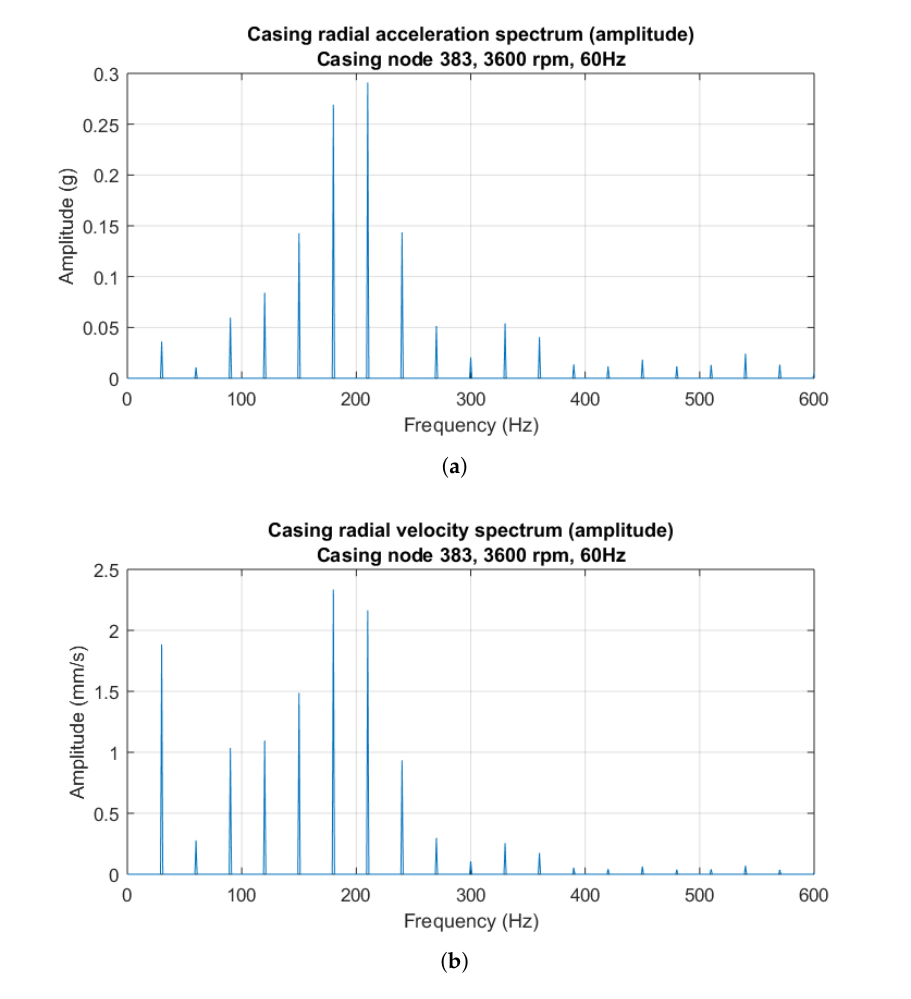
Figure 10. Periodograms of the steady-state casing signals with single-point rub and low-band details: ( a ) casing acceleration; and ( b ) casing velocity. For simplicity, only the low-band side of the spectra—between 0 and 600 Hz—is